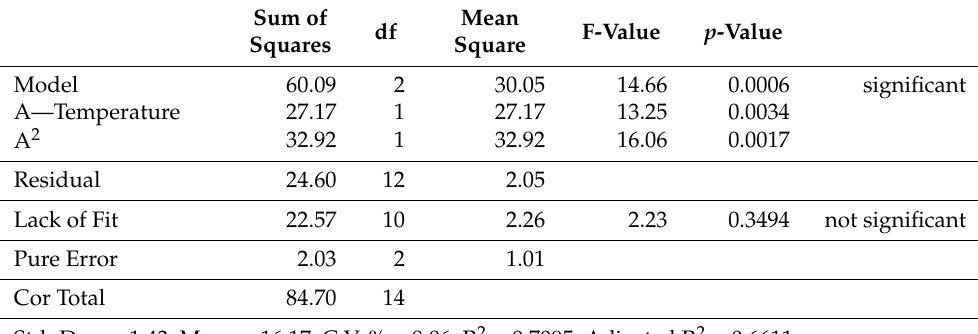
Table 7. Analysis of variance for antioxidant activity measured using DPPH